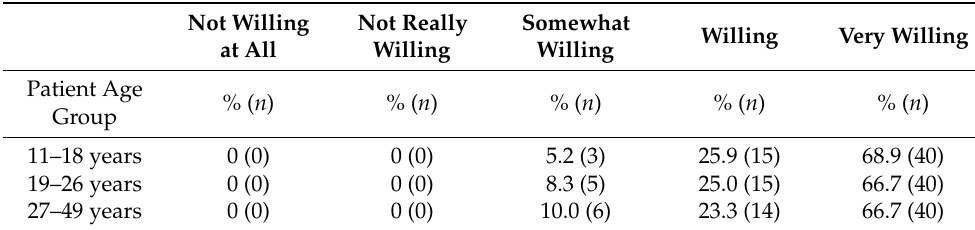
Table 2. Willingness of provider to refer an eligible patient for HPV vaccination in a community pharmacy, stratified by patient age group.